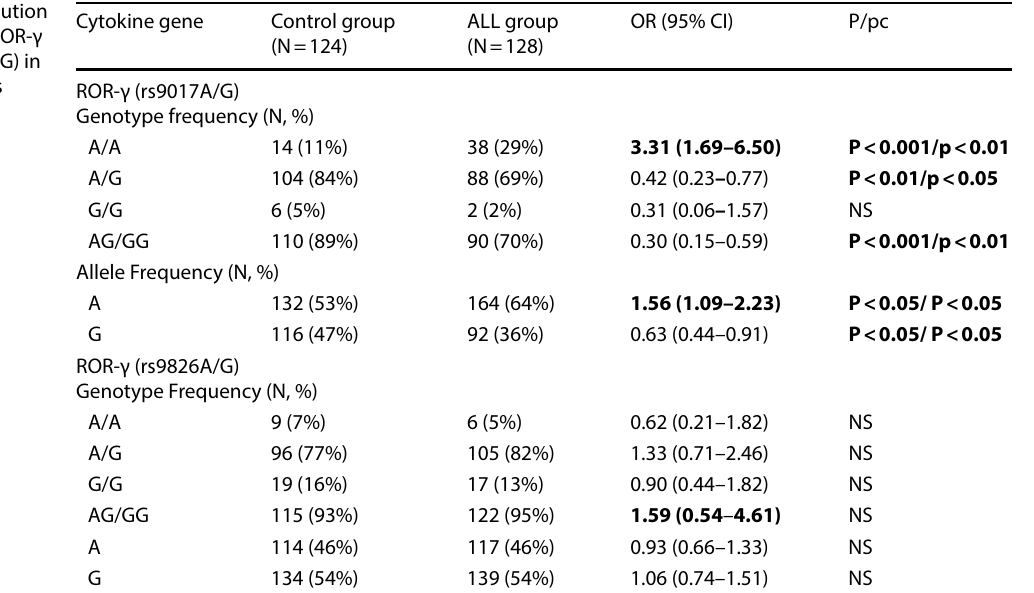
Table 3 Genotype distribution and allelic frequency of ROR-γ (rs9017A/G and rs9826A/G) in controls and ALL patients